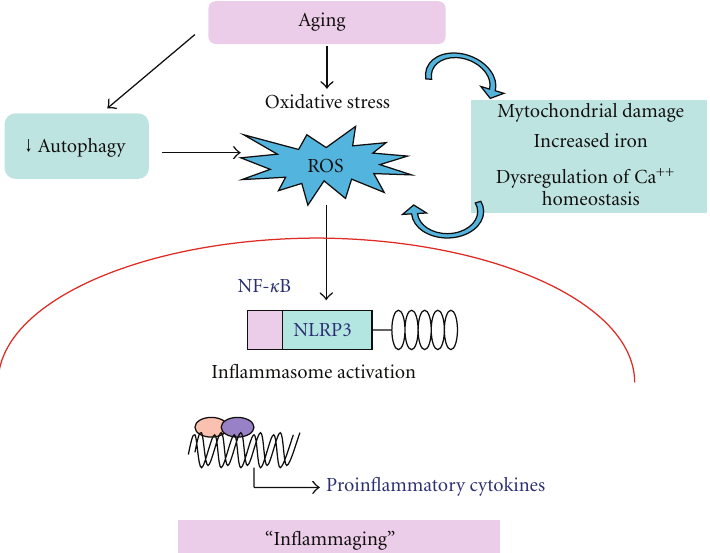
Figure 1: Oxidative stress and inflammation of aging. Abbreviations: ROS, reactive oxygen species; NF- κ B, nuclear factor κ B.